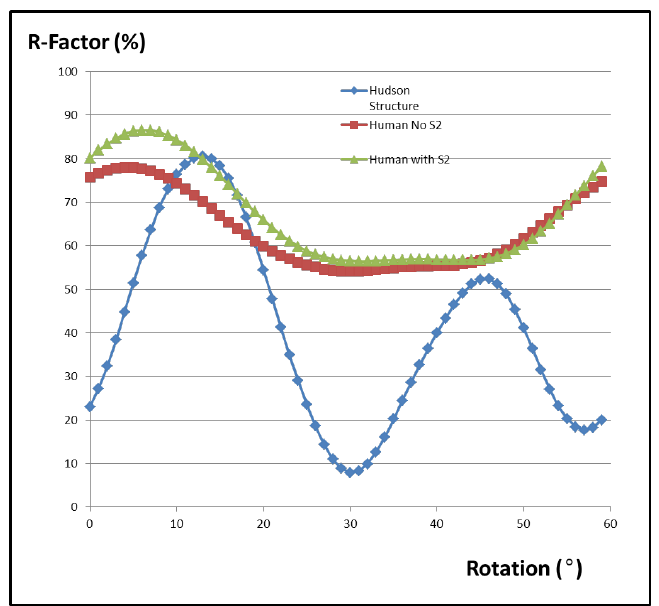
Figure 4. The calculated R-factor from the human heart muscle myosin filament in the fish muscle unit cell (red trace) showing a large variation with rotation angle relative to the unit cell axis. The analogous R-factor for the fish thick filament structure determined by Hudson et al. [10] is in blue. As expected, both R-factors are periodic because of the symmetry in the lattice and they repeat after 60 ◦ . Also included is the R-factor of the hybrid human system if the myosin S2 is also included. Inclusion of S2 gave a slightly poorer fit, but both human models with the interacting heads motif give very poor R-factors compared to the structure from Hudson et al. [10]. The R-factor for the chimera model was slightly improved if the 2D temperature factor was included (see text).